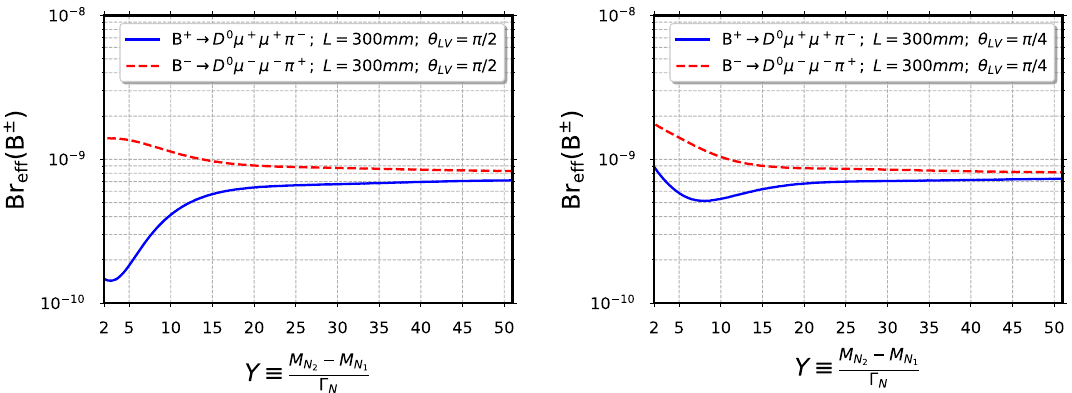
Fig. 4 Effective branching ratio as a function of Y for M N = 2 . 0 GeV, L = 300 mm and | B μ N | 2 = | B τ N | 2 = 10 − 5 . Left Panel: θ LV = π/ 2. Right panel: θ LV = π/